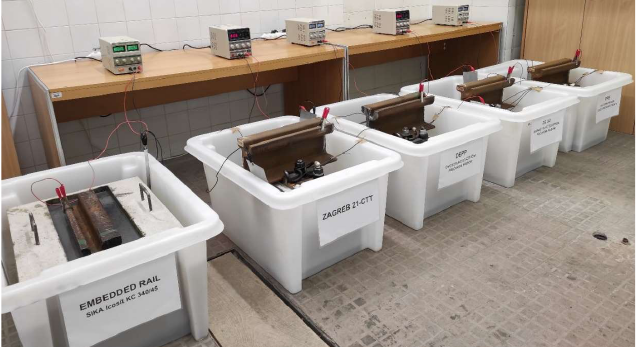
Figure 13. Samples before starting the experiment and electrical resistance measurement.